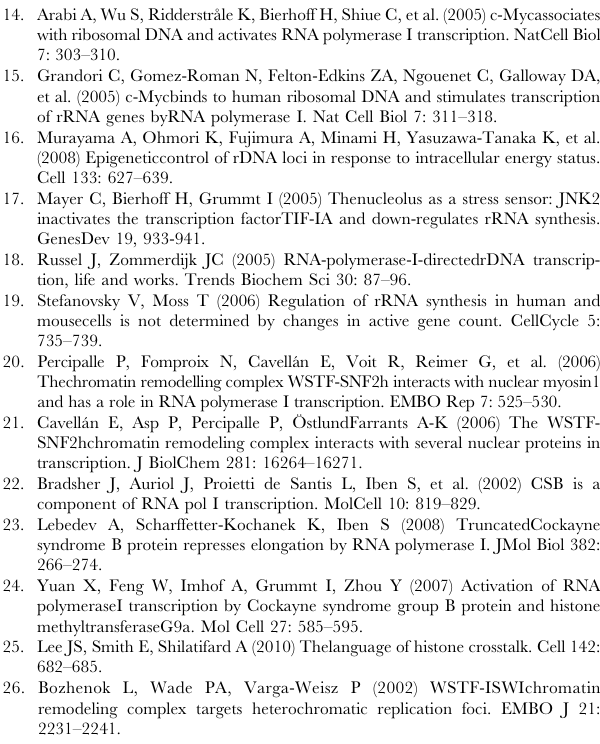
Figure S3 The 45S rRNA level and the WSTF protein level are reduced in serum-starved cells. ( A ) Immunoblot (7% SDS-PAGE) of 30 m g of cell lysates (0.7 M KCl) from growing cells, serum-starved cells and re-fed cells (9 h), using antibodies against WSTF, SNF2h, and NM1, as indicated at the left. Actin was used as a loading control. ( B ) 45S rRNA levels in growing cells and in serum-starved cells, detected from reverse transcriptase (Invitrogen) converted RNA preparations, and amplified with primer pair 0.3 kb (see Fig. 1C). Primer pair detecting actin was used as a control. Figure S4 Growing cells have low levels of H3-Ac along the rRNA gene. (A ) ChIP of growing cells (upper panel) and